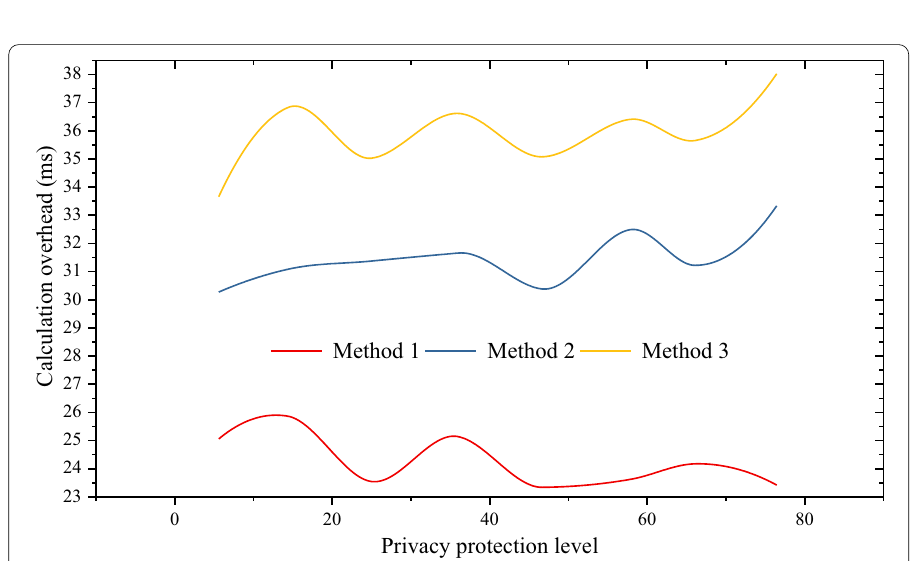
Fig. 7 Blockchain protection level and the impact of computational overhead-location recording